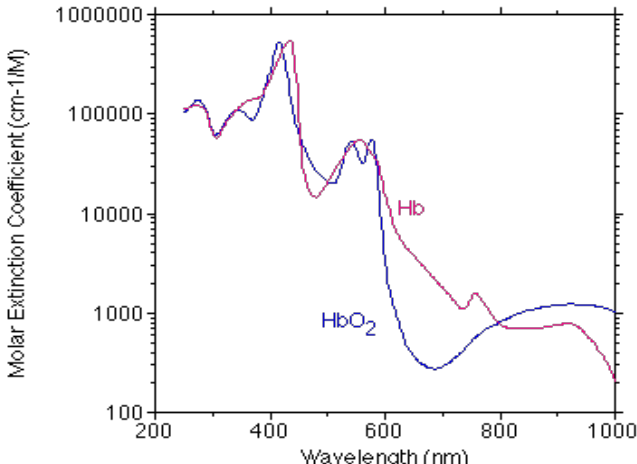
Figure 1. Molar extinction coefficients of oxygenated (blue curve) and deoxygenated hemoglobin (red curve) as a function of the wavelength in the visible and near infrared regions. Prepared by Scott Prahl from a variety of sources [3] and is presented with permission from Dr. Prahl.